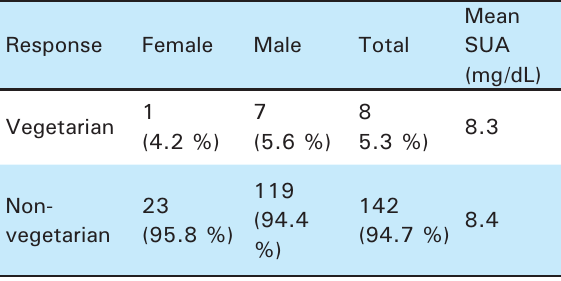
Figure 2. Age adjusted serum uric acid level among gouty arthritic males and females Food habit, gout and serum uric acid level Only 8 out of 150 patients (5.3 %) were either vegetarians or had not consumed meat and other meat products for more than fi ve years. The ratio of non- vegetarians to vegetarians was 17.75 : 1 suggesting that most of the cases took meat and meat products. The mean SUA levels among the vegetarians and non-